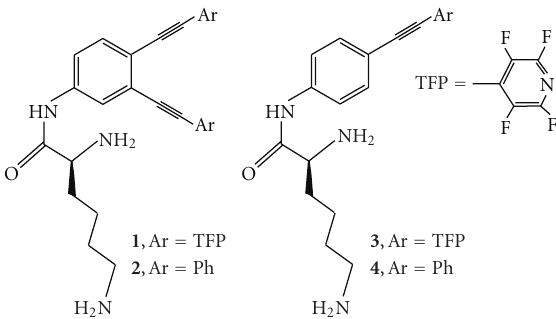
Figure 1: Structures of C-lysine conjugate.